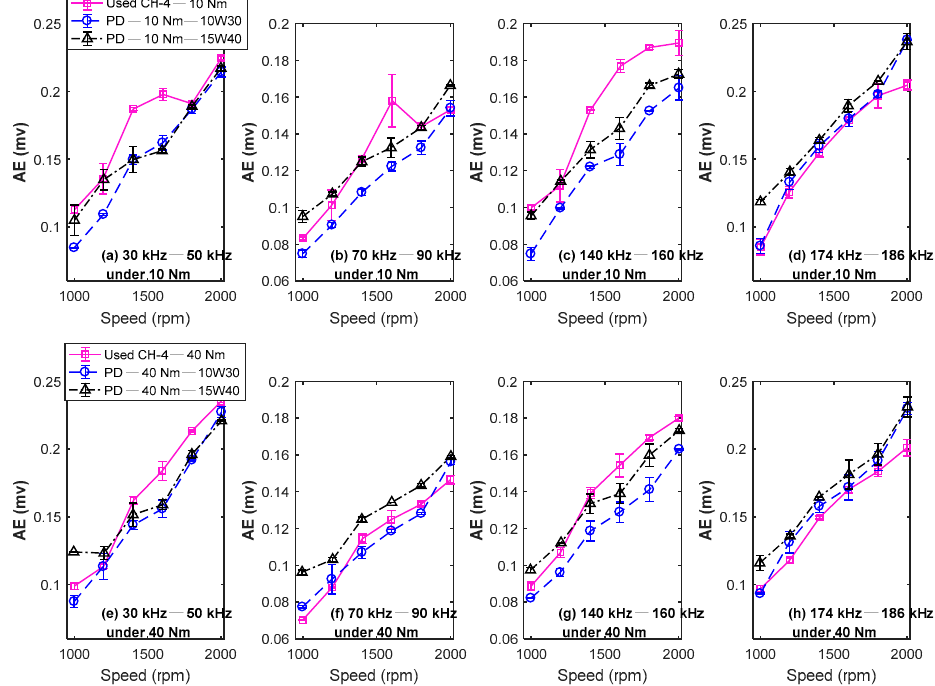
Figure 12. AE indicators in power stroke for different oils and operating conditions.